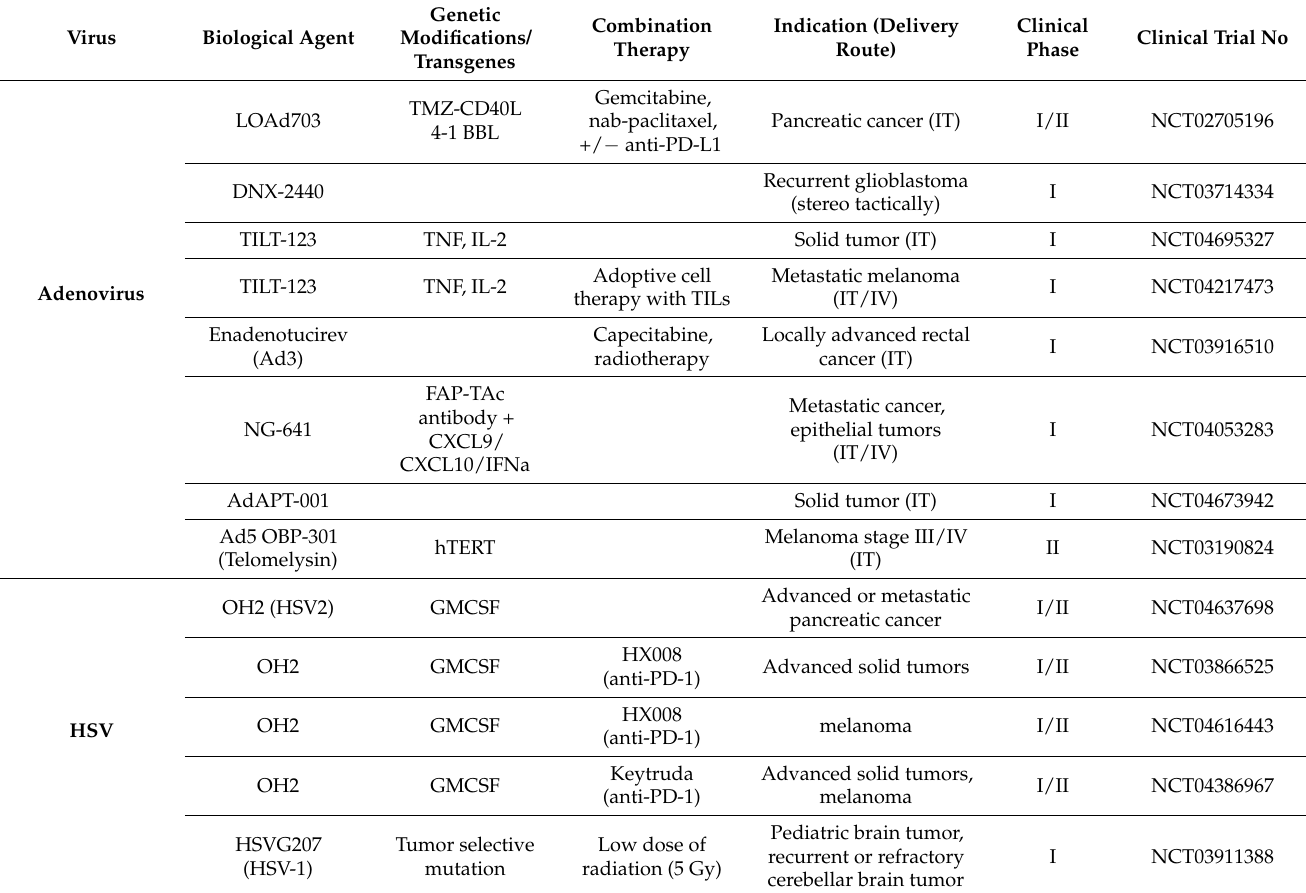
Table 3. List of selected oncolytic viruses currently in clinical trials.